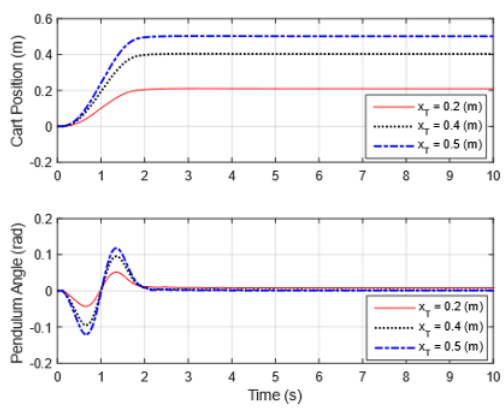
Fig. 5. Trajectory with different target position at same terminal time.